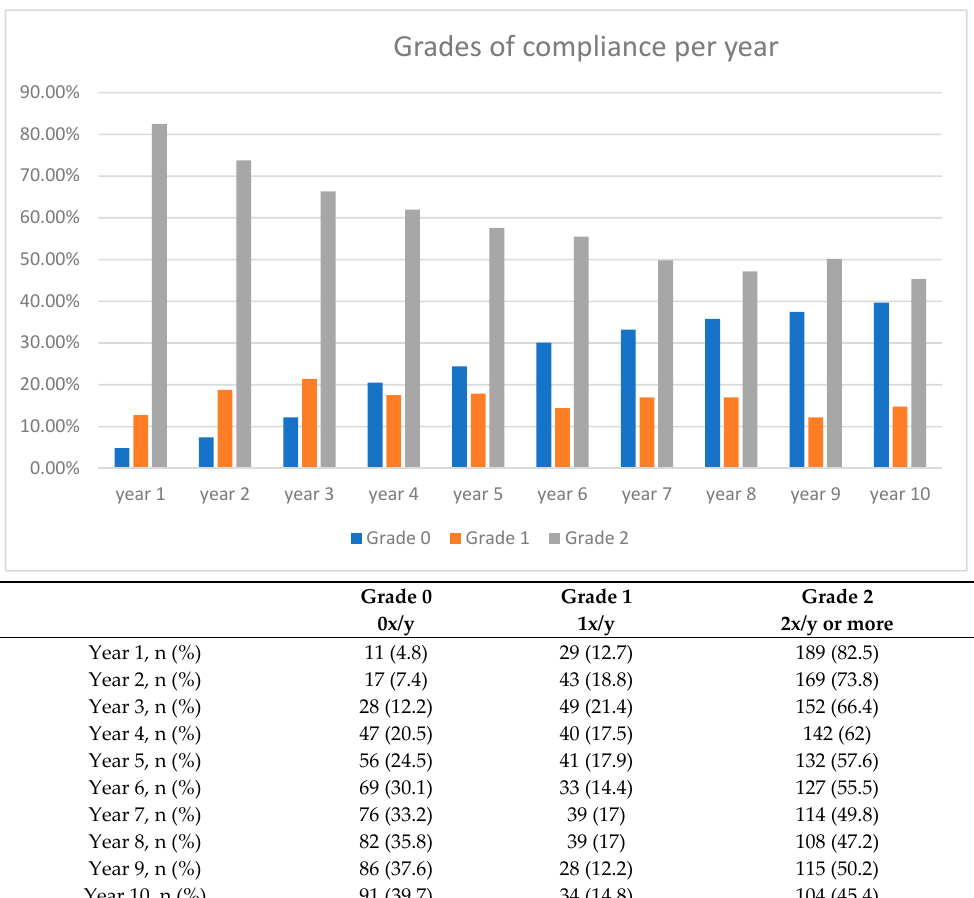
Figure 1. Overview of the grades for compliance according to each year.